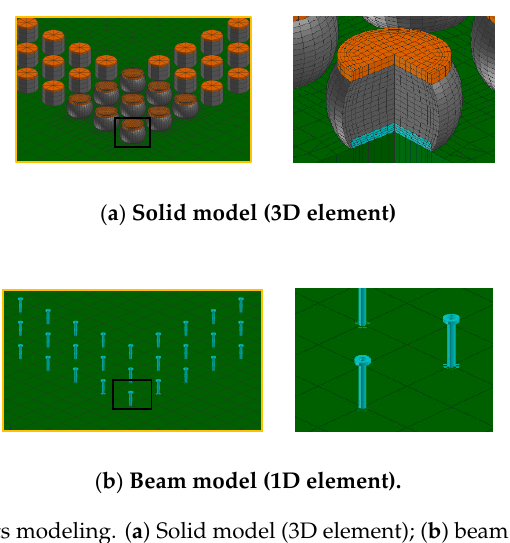
10 of 13 Figure 14. Beam model: ( a ) spring-beam element connection between the two surfaces, ( b ) multi-point kinematic constraint. According to the solder joints geometry, solid model and beam model are considered for element type as shown in Figure 15. In addition, Table 5 describes the comparison between the two models in terms of computing efficiency. Larger mesh size shortens the number of the elements that results in dramatic reduction of the required computing time. To confirm the feasibility of the beam model, first, the dynamic responses at the BGA package ② with fixture I are compared for both the models. Figure 16 shows the comparison of the solid model and the beam model for the BGA solder joint at 0.55 ms after impact loading. The displacement contour is shown in Figure 16a. The displacement response of the beam model almost matches that of the solid model. The discrepancy of the maximum out-of-plane displacement was found only 0.06 mm between the two models. Next, the resulting force and the stress of solder joint is studied between the beam and the solid models. Since the beam model produces the moment followed by the force at the spring-beam